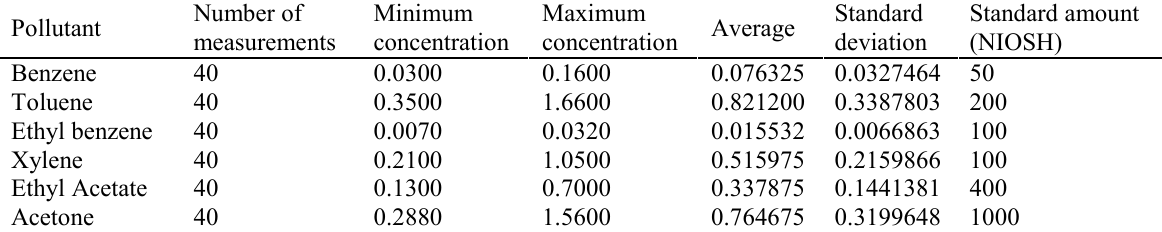
Table 2. The range of concentrations of volatile organic compounds (PPM) Number of Minimum Maximum Pollutant measurements concentration